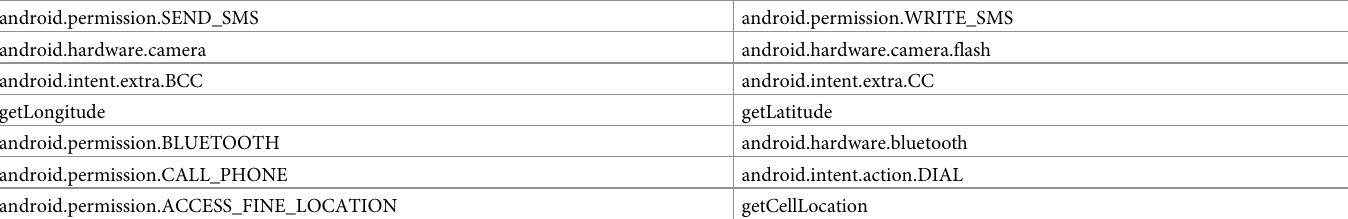
Table 9. Some of the selected feature pairs with strong relationships.